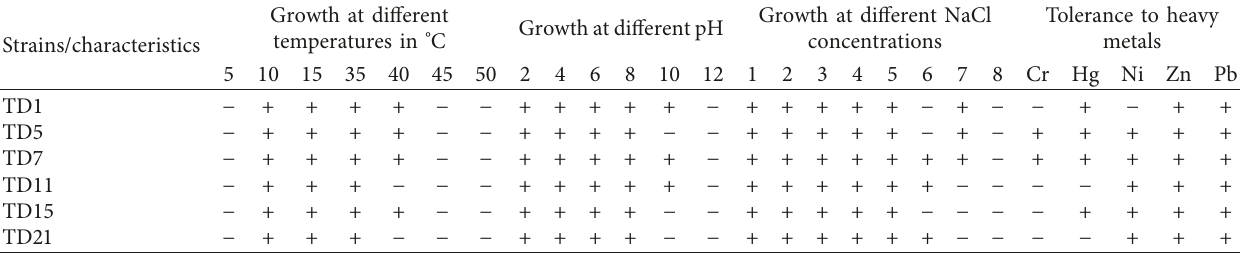
Table 2: Physiological stress tolerance testing of six potent Trichoderma strains under various conditions. Strains/characteristics